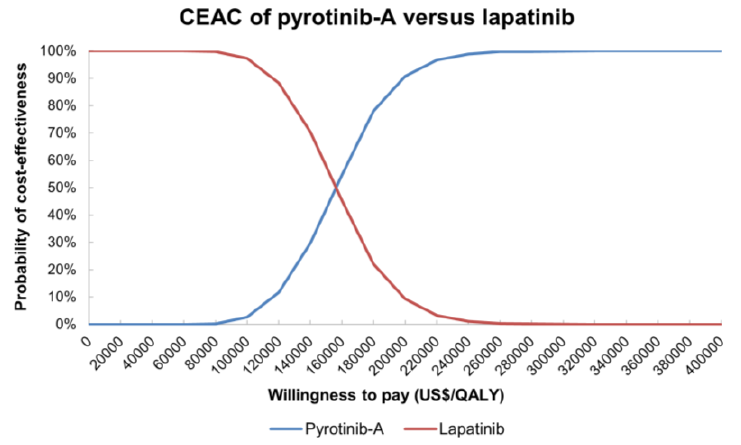
Figure 5. Cost-effectiveness acceptability curve between pyrotinib-A plus capecitabine and lapatinib plus capecitabine. Notes: Blue line indicates pyrotinib-A regimen, and red line indicates lapatinib regimen. Abbreviations: CEAC, cost-effectiveness acceptability curve; pyrotinib-A, pyrotinib before being enrolled in National Reimbursement Drug List; QALY, quality-adjusted life-year.